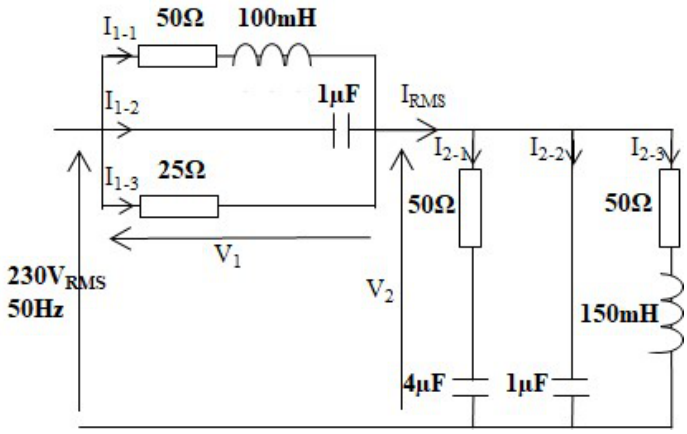
Figure 9. Particular case proposed to students to verify their